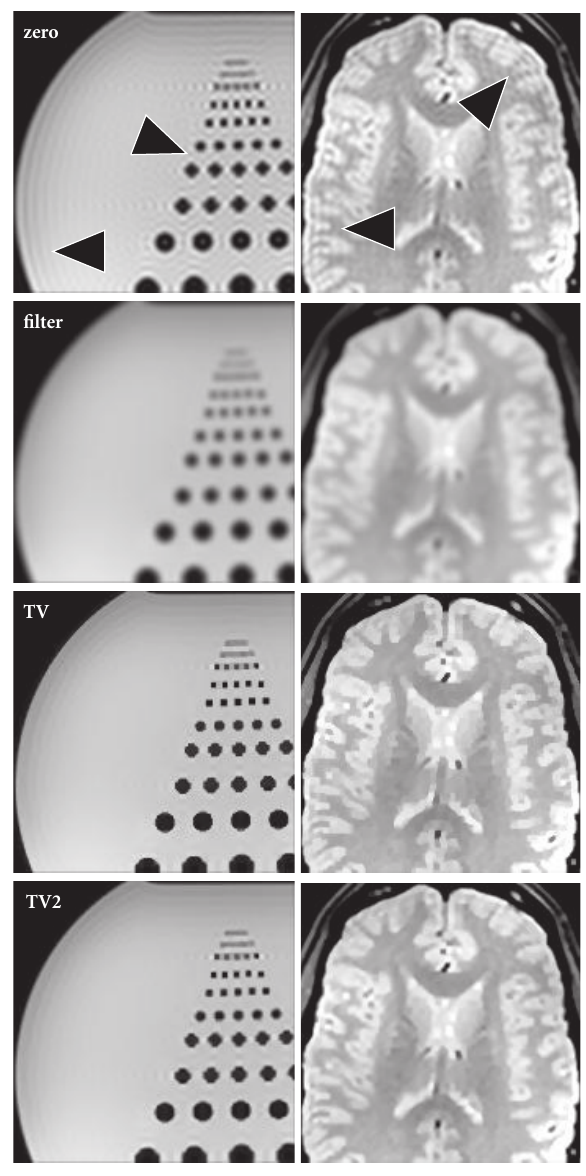
Figure 3: Spin-echo images (96 × 96 samples, 288 × 288 recon- struction matrix) of (left) a phantom (TR/TE = 4000/8 ms, BW 243 Hz/pixel, FA 70 ◦ , 3 mm slice) and (right) a human brain in vivo (TR/TE = 4000/25 ms, BW 180 Hz/pixel, FA 90 ◦ , 2mm slice) using zero-padding (zero), filtered zero-padding (filter), the proposed extrapolation method with first-order (TV), and additionally second-order derivatives (TV2). Arrows = truncation